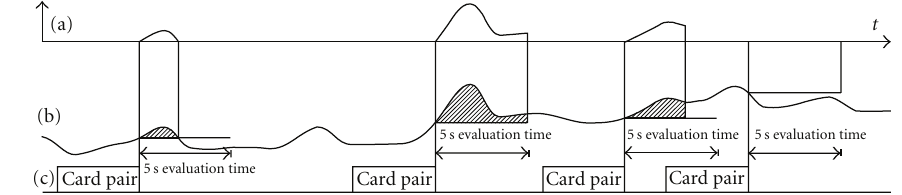
Figure 4: SCR parametrization used in this study (a). Skin conductance level (b). Card show events